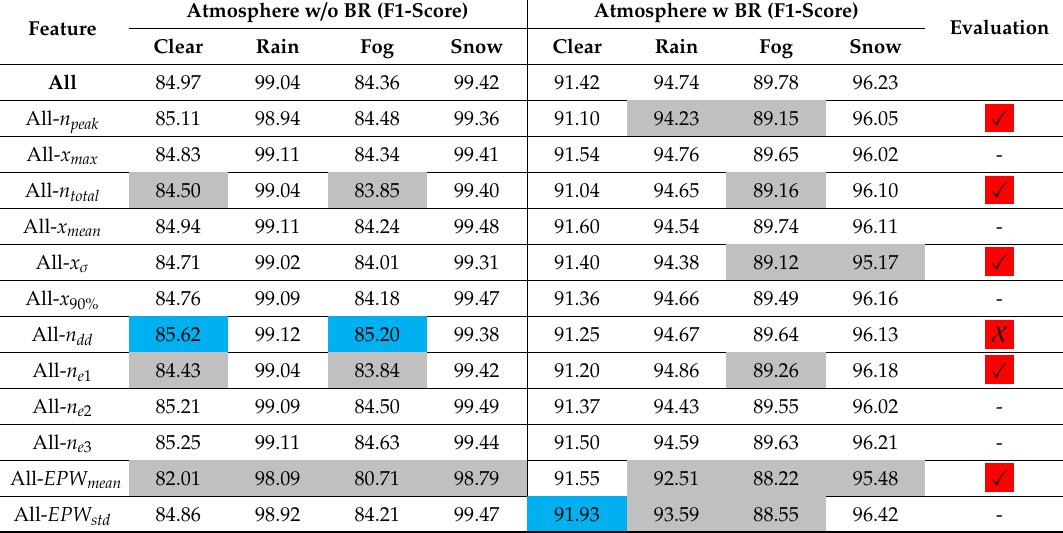
Table 7. Results of the feature ablation analysis for the atmosphere region using the F1-Score as evaluation parameter. In comparison with the score using all features, the features are marked with (cid:88) when the F1-Score for two or more classes decreases more than 0.4 (marked in grey), with X when increases more than 0.4 (marked in blue) and with - in other cases (All- EPW std is marked as neutral because the F1-Score of Clear